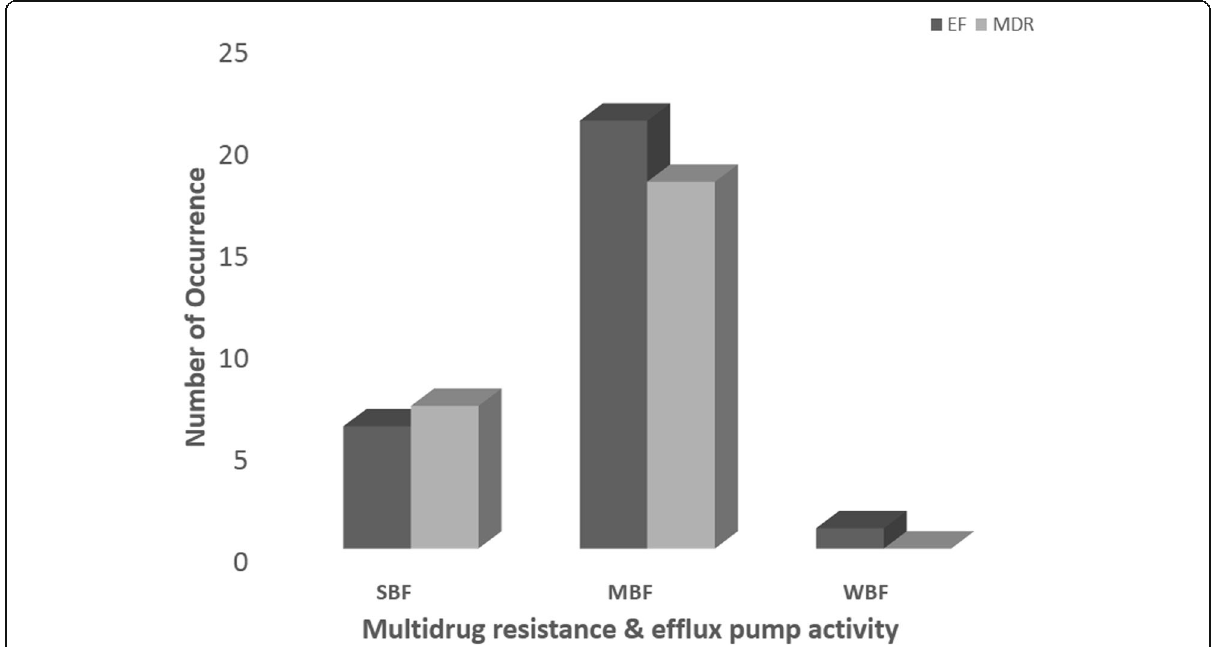
Fig. 2 Occurrence of multidrug resistance and efflux pump activity of biofilm forming isolates. SBF: Strong biofilm formers, MBF: Moderate biofilm former, WBF: Weak biofilm former, EF: Efflux pump activity